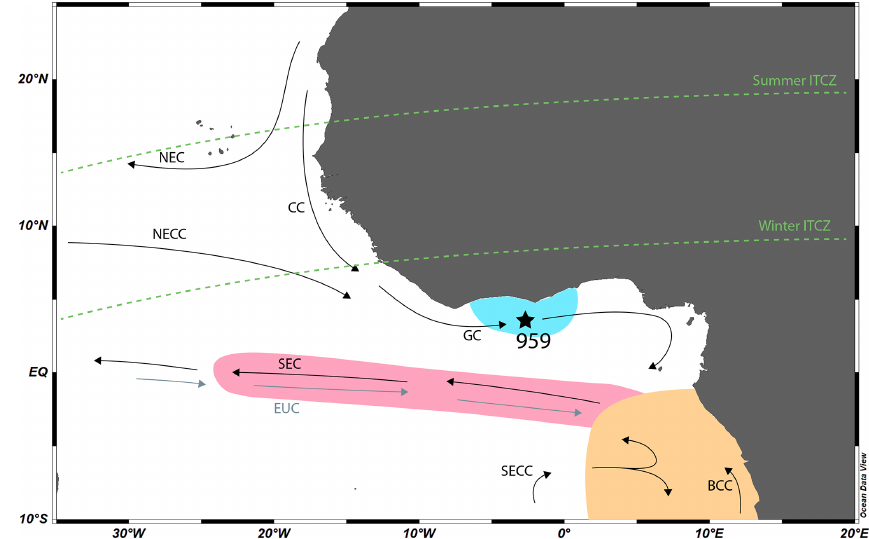
Figure 1. General surface currents and upwelling areas in the Eastern Equatorial Atlantic. Blue shading: coastal upwelling in boreal summer; pink shading: equatorial upwelling; orange shading: permanent coastal upwelling. NEC: North Equatorial Current; NECC: North Equatorial Counter Current; CC: Canary Current; GC: Guinea Current; SEC: South Equatorial Current; EUC: Equatorial Undercurrent; SECC: South Equatorial Counter Current; BCC: Benguela Coastal Current. Green stippled lines mark the annual range of the Intertropical Convergence Zone (ITCZ). Figure after Norris (1998), Wagner (1998), and Wiafe and Nyadjro (2015). Map generated with Ocean Data View (Schlitzer,